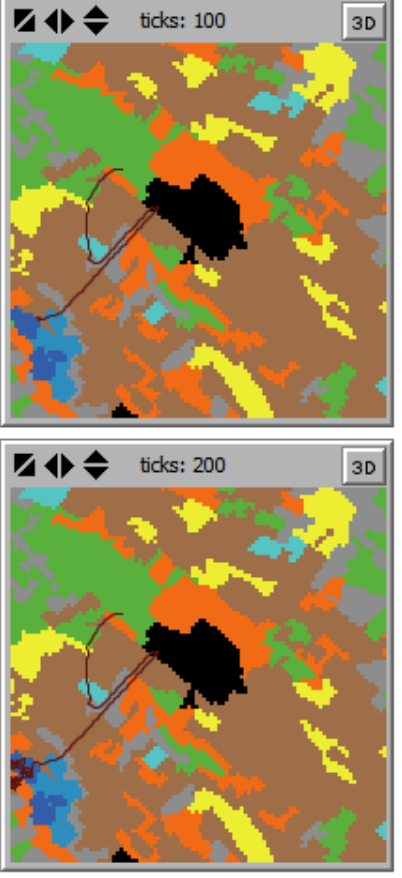
Figure 7. The path of agent that always moves toward an unvisited type of land. Having visited all possible land types, it starts wandering.